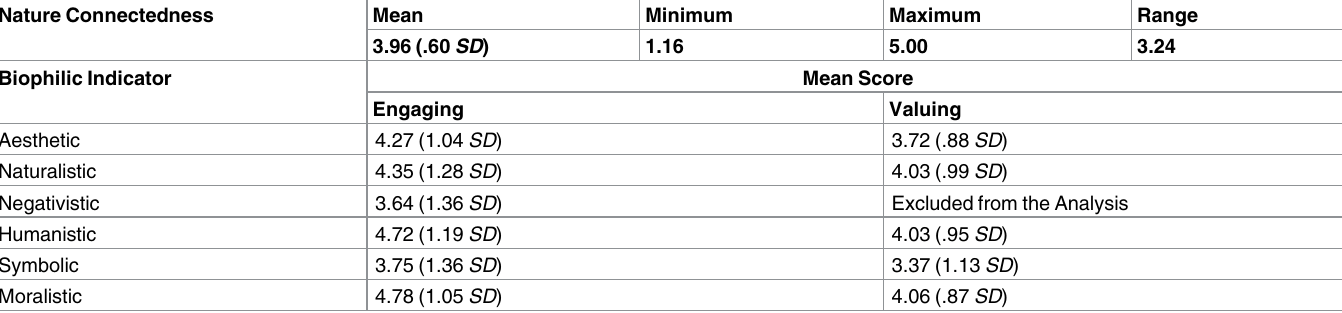
Table 9. The mean engagement scores for the engaging and valuing indicators (N =